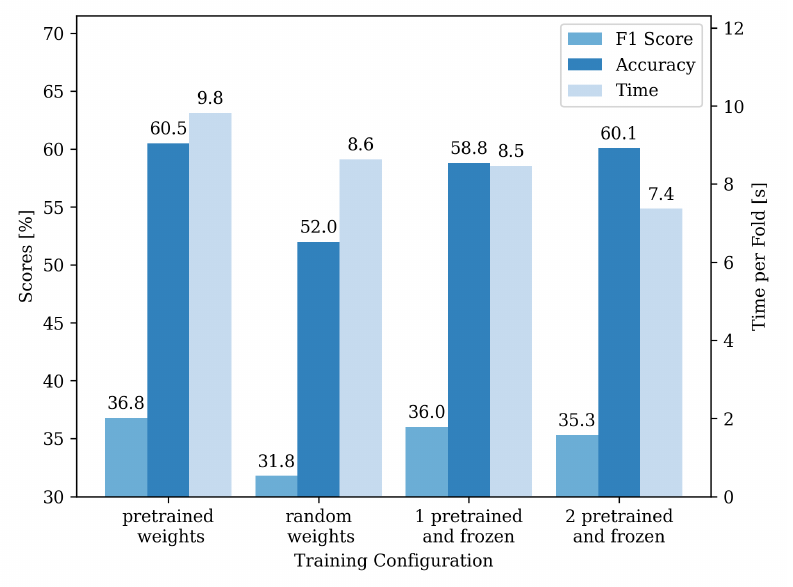
Figure 8. Comparison of the accuracy, F1 score, and training time for different transfer learning configurations for a reduced dataset, i.e., without data augmentation. The scale for the accuracy and F1 score is shown on the left y -axis and for the training time on the right y -axis. In the configuration of the pre-trained weights, all three convolutional layers were initialized, with the weights of the network trained on volleyball data but not frozen. For the random weights configuration, all layers were randomly initialized. For the configurations with one or two frozen layers, the model is initialized with pre-trained weights, and the weights are frozen in the later training